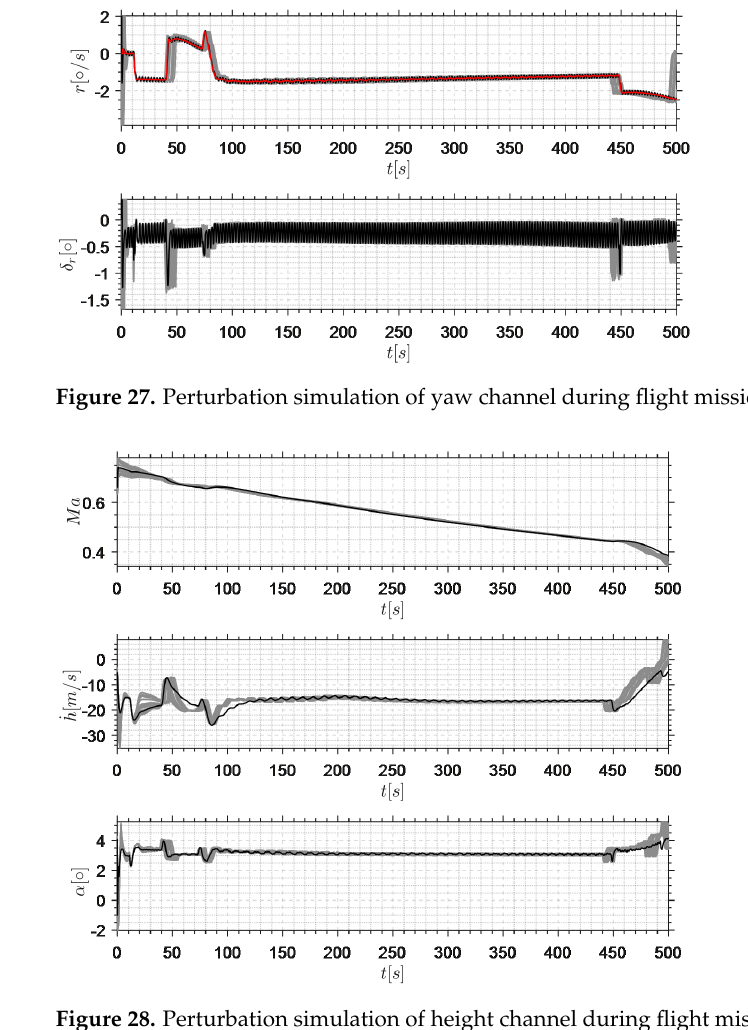
Figure 28. Perturbation simulation of height channel during flight